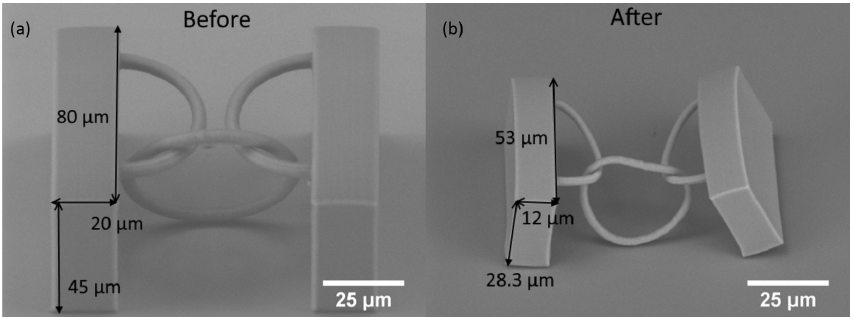
Figure 9. SEM images of the structure consisting of supporting walls and free hanging ring before (a) and after (b) pyrolysis. Magnification is the same. Fabricated objects appear brighter after pyrolysis, which indicates a change in the electrical conductivity of the material.